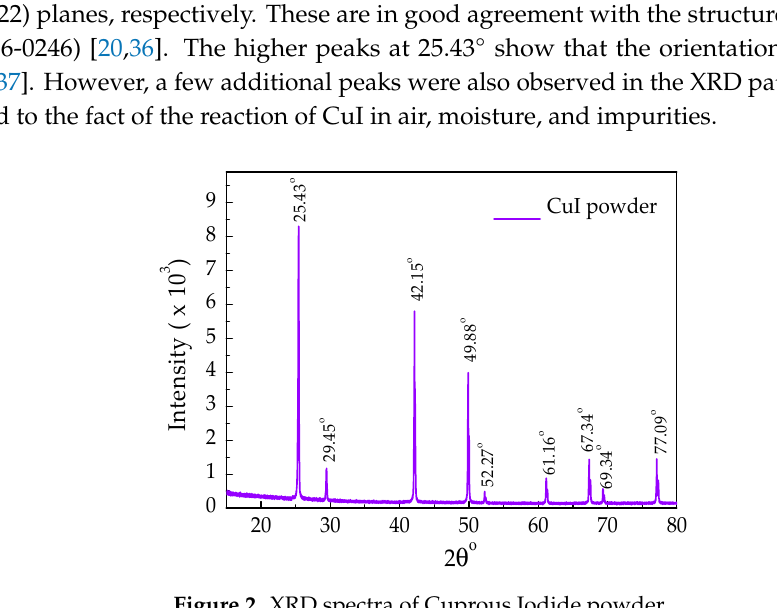
Figure 2. XRD spectra of Cuprous Iodide powder.